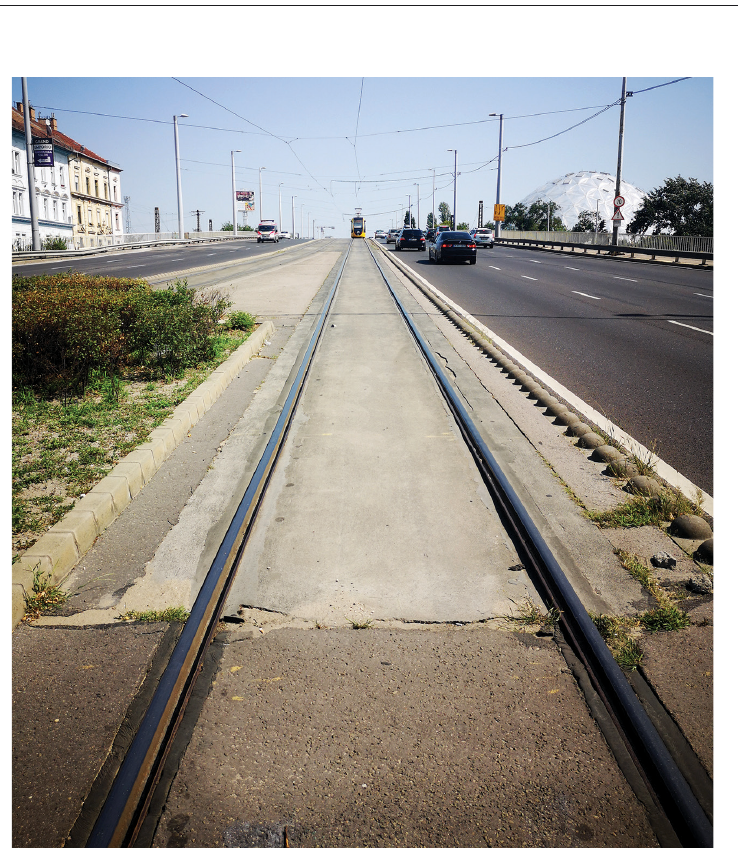
Figure 12. Section 3, 2021 (authors’